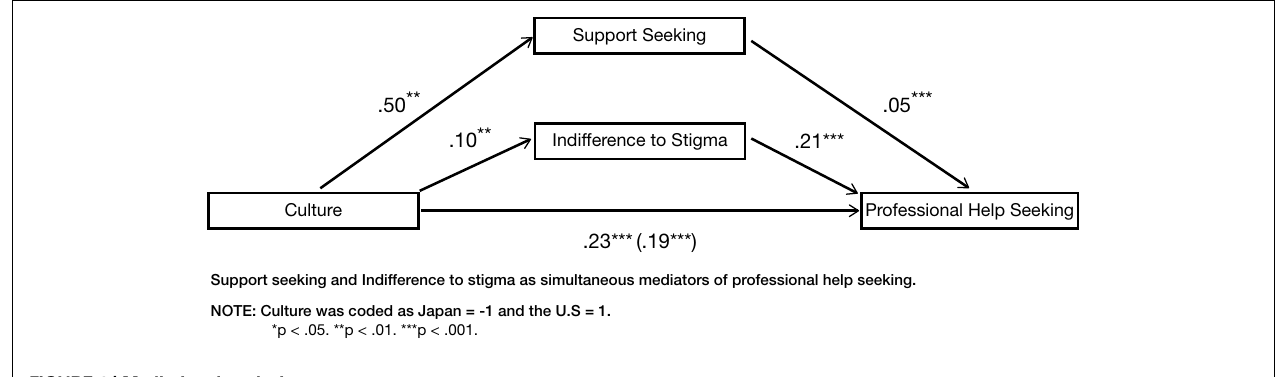
FIGURE 1 | Mediational